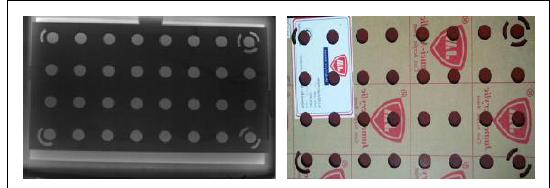
Figure 2. Calibration checkerboard image by a thermal camera (Left) and Calibration checkerboard view by an optical camera